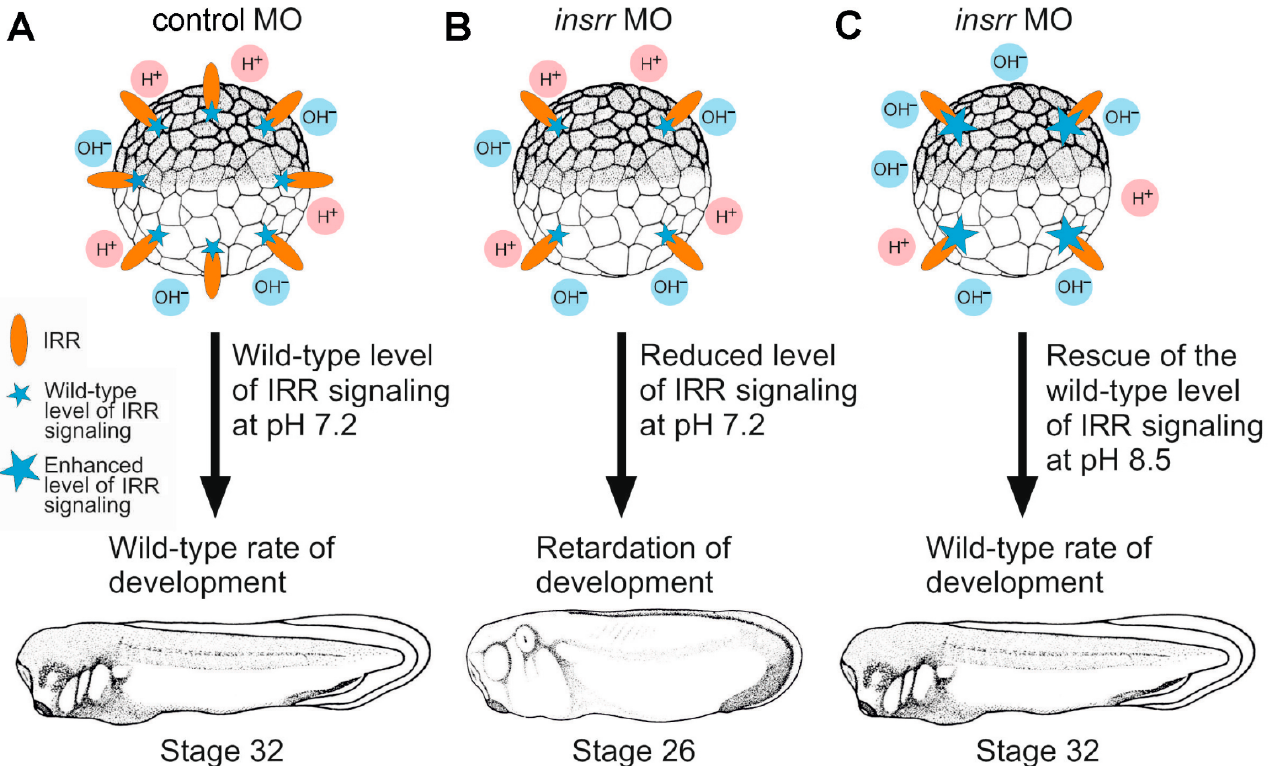
Figure 4. A model of the regulation of embryonic development by IRR. ( A ). In embryos injected with the control MO and at the neutral pH (7.2), the level of IRR signaling is enough to ensure the wild-type rate of embryonic development. ( B ). If insrr is downregulated by injection of insrr MO, the concentration of IRR molecules significantly but not completely decreases. As a result, at neutral pH (7.2) a decreased level of IRR signaling leads to the retardation of development. ( C ). At alkaline pH (8.5), despite the concentration of IRR molecules being significantly decreased in embryos injected with insrr MO, the level of the IRR signaling enhances, which ensures the wild-type rate of embryonic development.